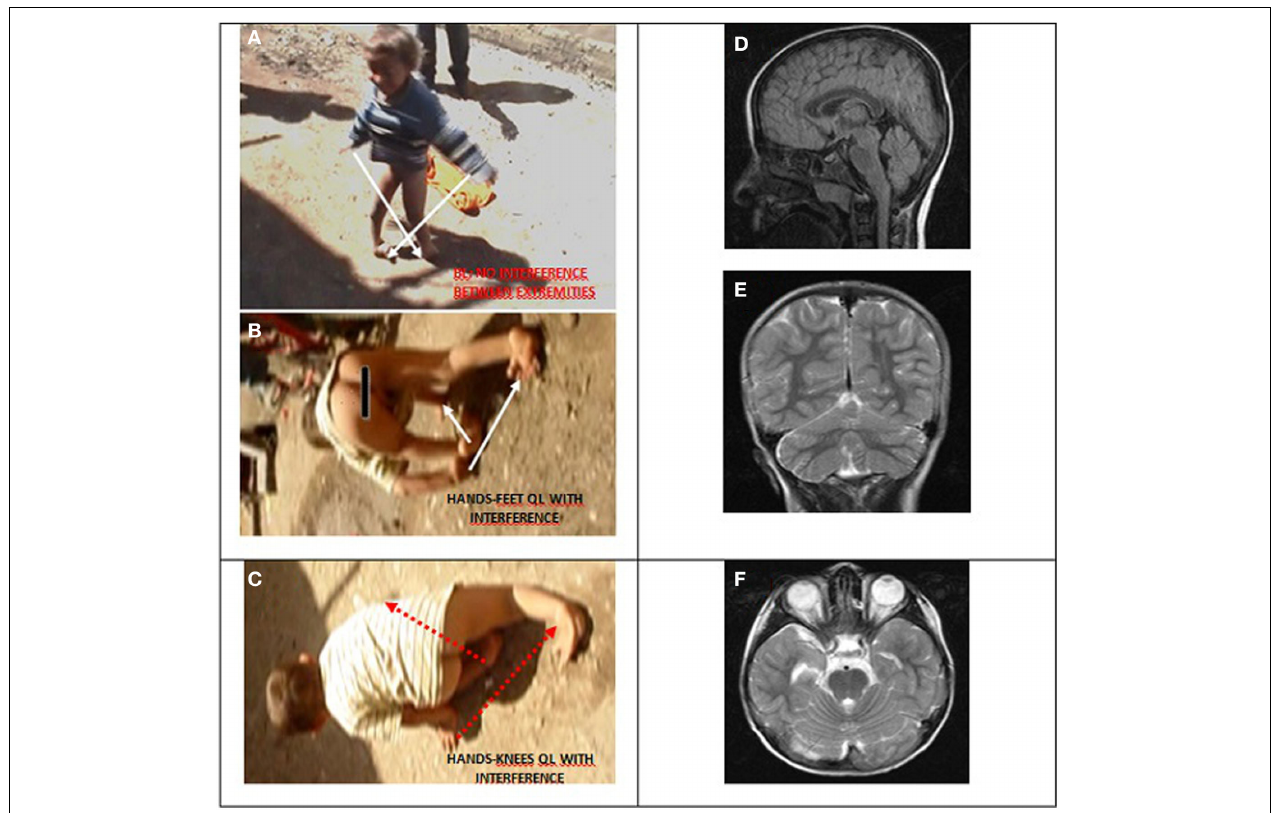
FIGURE 9 | Case IV-30, 5 years old male with congenital talipes equinovarus in both feet. (A) Diagonal-sequence BL: right arm-left leg and left arm-right leg (see arrows). (B) Diagonal-sequence QL on hands and feet: